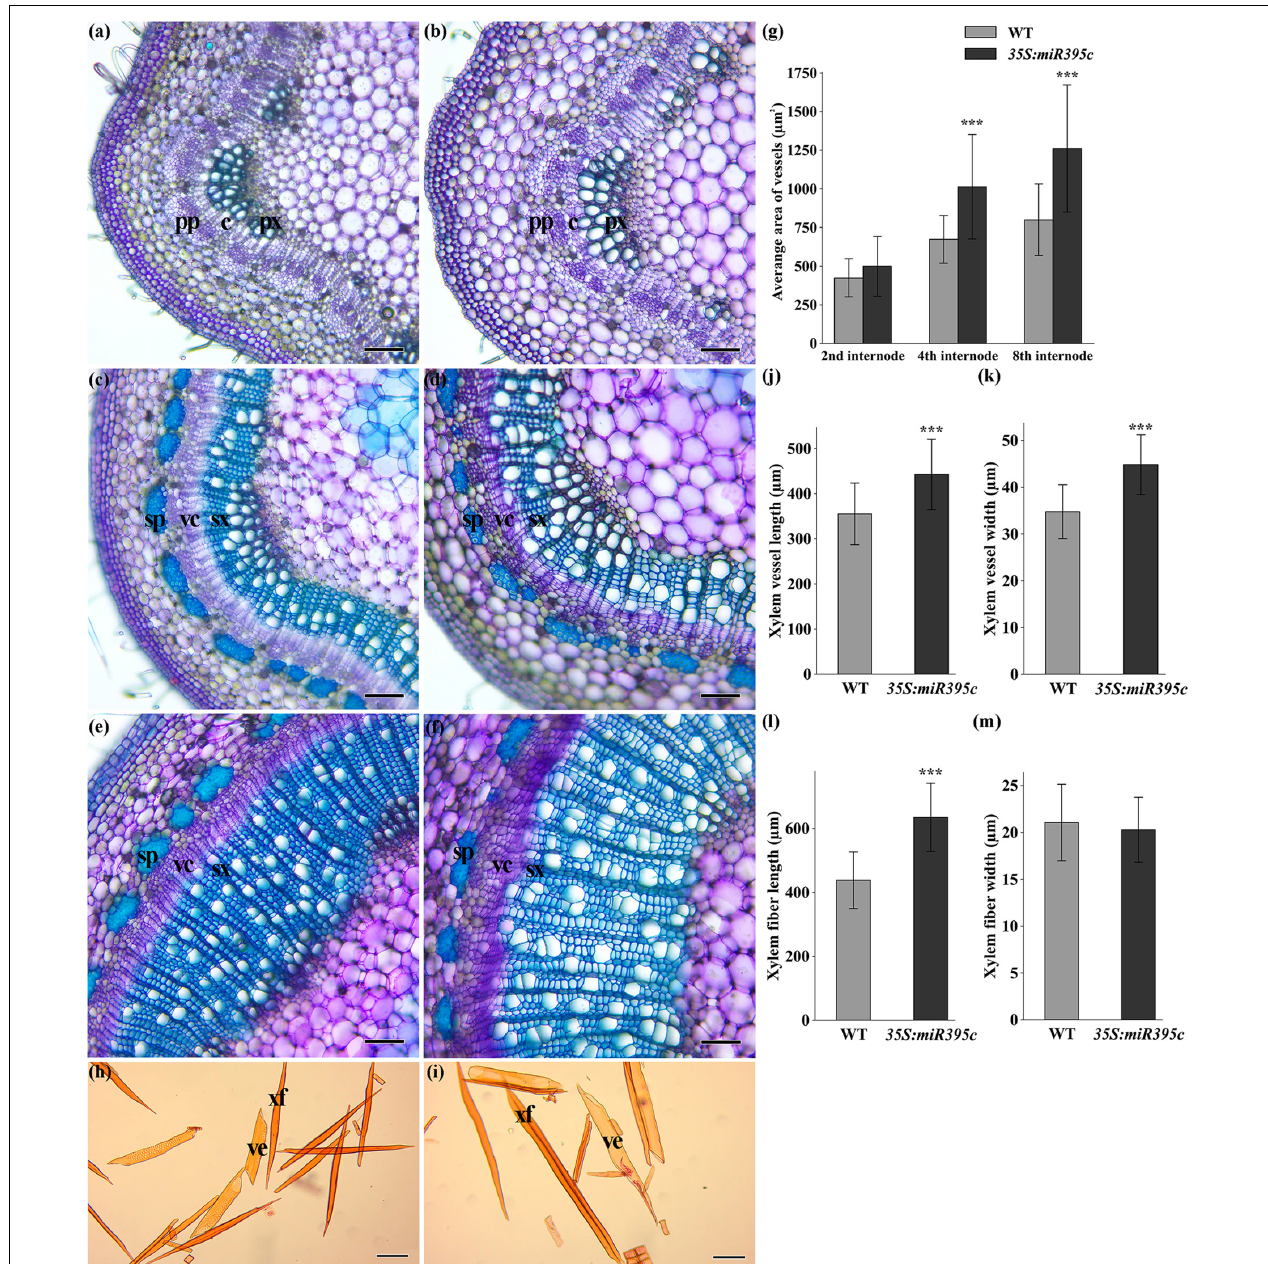
FIGURE 3 | Cross-sections of 2nd, 4th, and 8th internodes in 3-month-old wild-type and transgenic 84K poplars. (a) Cross-section of the 2nd internode in wild type. (b) Cross-section of the 2nd internode in miR395c-OE poplar. (c) Cross-section of the 4th internode in wild type. (d) Cross-section of the 4th internode in miR395c-OE poplar. (e) Cross-section of the 8th internode in the wild type. (f) Cross-section of the 8th internode in miR395c-OE poplar. pp, primary phloem; px, primary xylem; c, cambium; vc, vascular cambium; sp, secondary phloem; sx, secondary xylem. (g) Average area of vessels increased in transgenic plants. (h) Separation and safranin staining of secondary xylem cells in wild-type poplar. (i) Separation and safranin staining of secondary xylem cells in miR395c-OE poplar. Bar, 100 µ m. xf, xylem fiber; ve, vessel. (j) Xylem vessel length increased in miR395c-OE poplar. (k) Xylem vessel width increased in miR395c-OE poplar. (l) Xylem fiber length increased in miR395c-OE poplar. (m) Xylem fiber width changed slightly in miR395c-OE poplar. Asterisks indicate significant difference between transgenic and WT plants using the Student’s t -test, *** p <